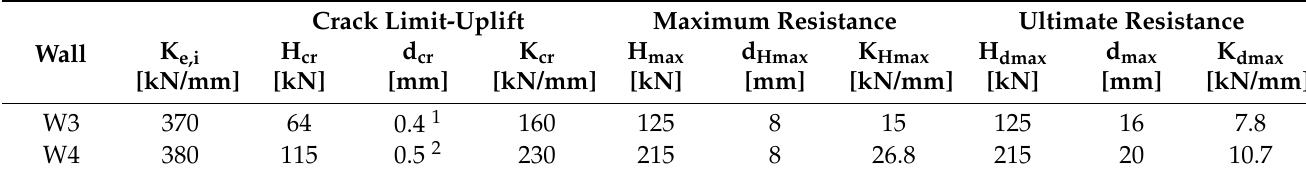
Table 6. Resistance and deformability parameters for jacketed walls W3 and W4 ( σ v = 0.4 N/mm 2 ). Crack Limit-Uplift Maximum Resistance Wall